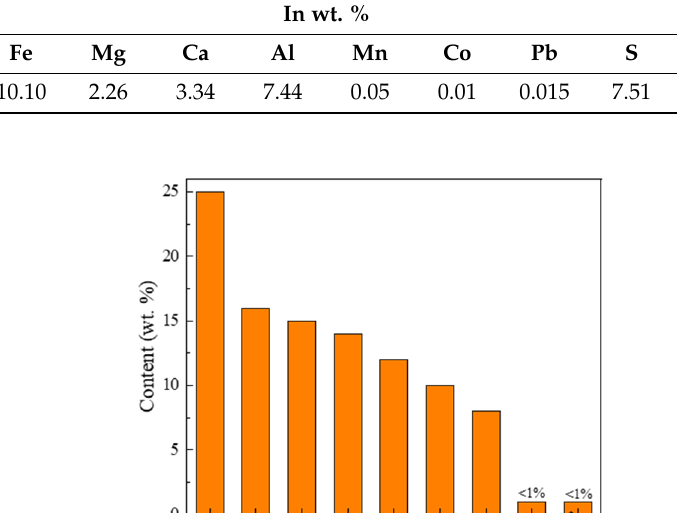
Table 1. Main elemental content of the flotation tailing samples used in present study. In wt. %